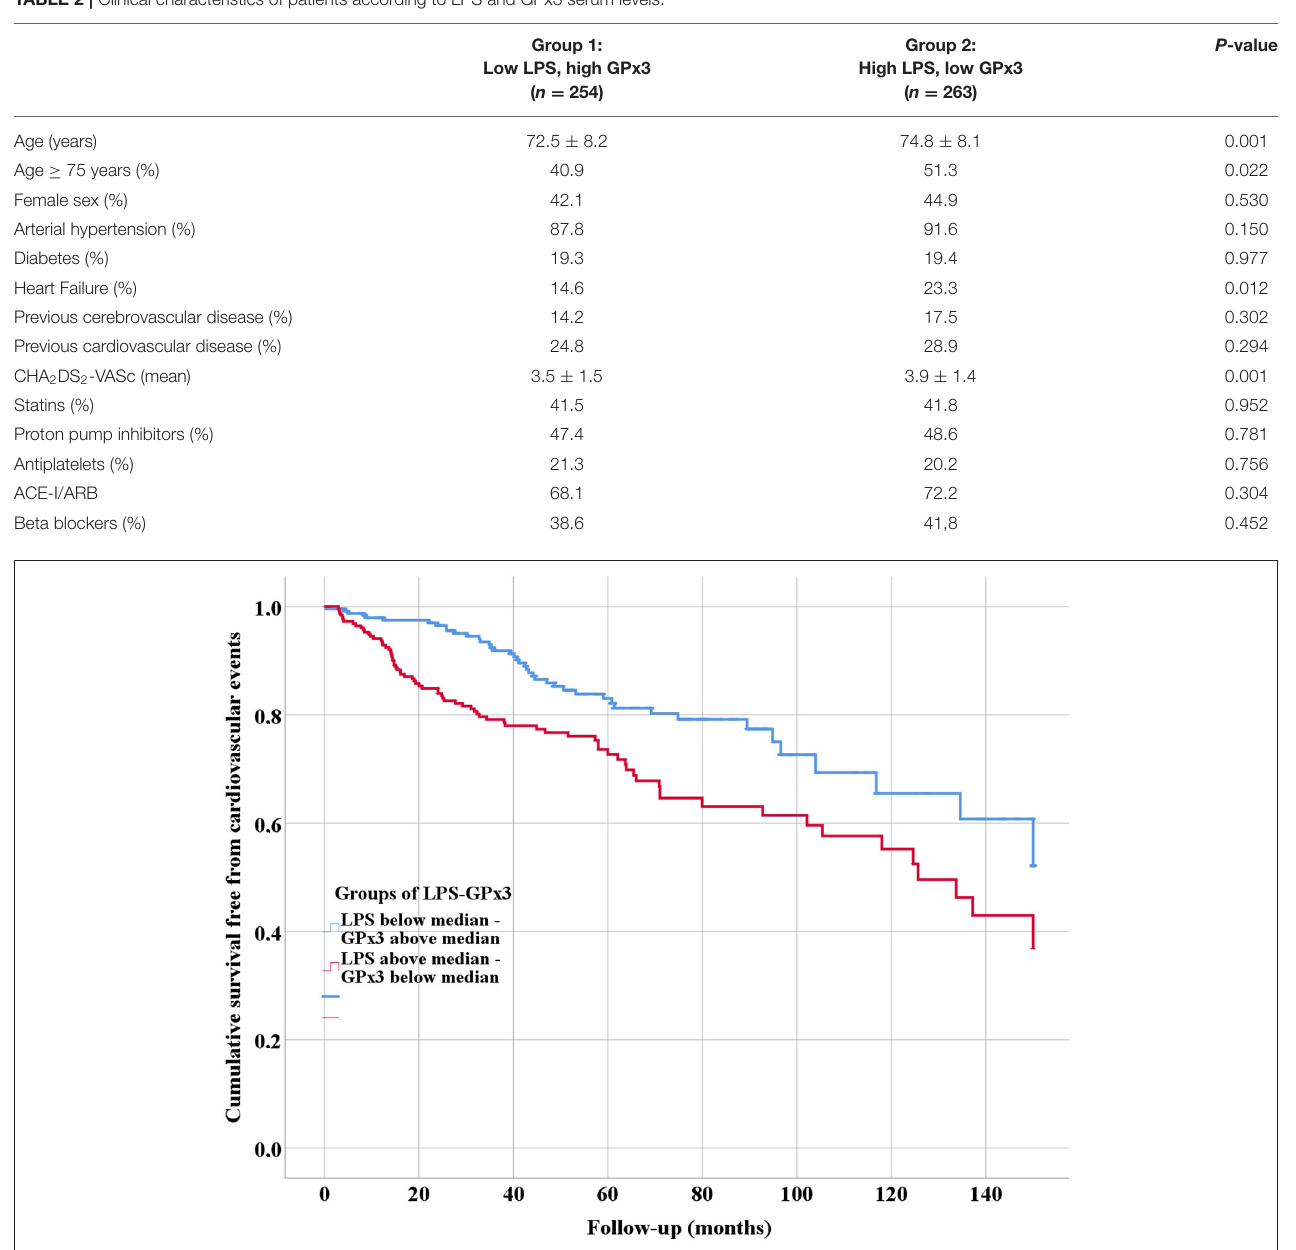
FIGURE 1 | Kaplan-Meier survival curves of cardiovascular events, according to serum levels of lipopolysaccharides (LPS) and glutathione peroxidase 3 (GPx3).